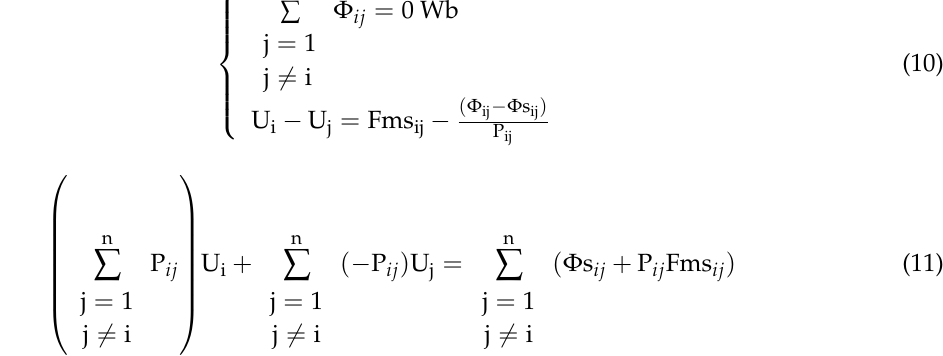
Figure 25. Mesh equation setting for the i th node.